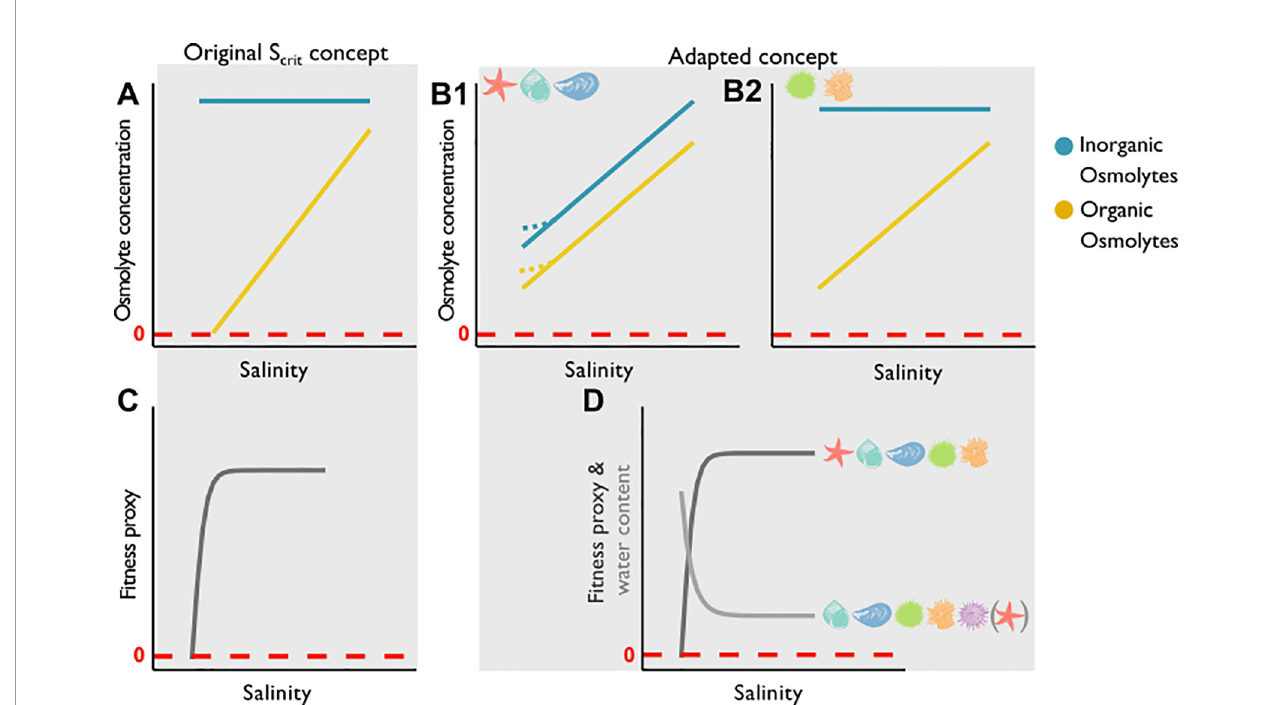
FIGURE 7 | Depicted are hypotheses on how salinity affects the osmolyte pool in combination with idealized fi tness parameters and tissue water content. The blue lines mark the inorganic osmolyte pool, the yellow lines mark the organic osmolyte pool. The dashed red lines marks zero. Panel (A) shows the original S crit concept for the total organic osmolyte pool. A linear decrease of organic osmolytes is shown until the organic osmolyte pool is fully depleted while inorganic ion concentration is constant. S crit is de fi ned as the point when the organic osmolyte pool is depleted. Panel (B) shows an altered concept of two scenarios that show a S crit range which incorporates the inorganic and organic osmolyte pool). In scenario B1 both pools decrease with salinity [in some species these concentrations stabilize at low salinities (dashed yellow and blue lines)], but concentrations do not reach zero. Scenario B2 shows a decrease with salinity in the organic pool, but concentrations do not reach zero, while the inorganic pool remains constant. (C) Depicted is a fi tness proxy (e.g. survival; dark grey) in relation to salinity, which according to the S crit concept reaches zero when the organic osmolyte pool is depleted. (D) Here we see a fi tness proxy that drops rapidly after a low-salinity threshold is reached (i.e. survival), meanwhile tissue water content (light grey) increases below this limit. The species symbols in panels (B, D) symbolize if the suggested concept applies to the investigated species in this